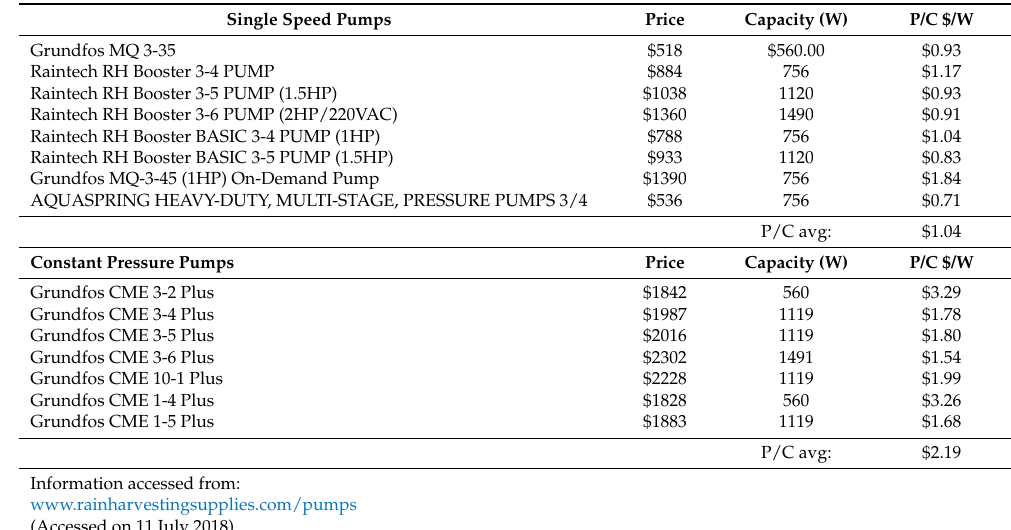
Table A8. Price per capacity scaling factor calculations for pumps.